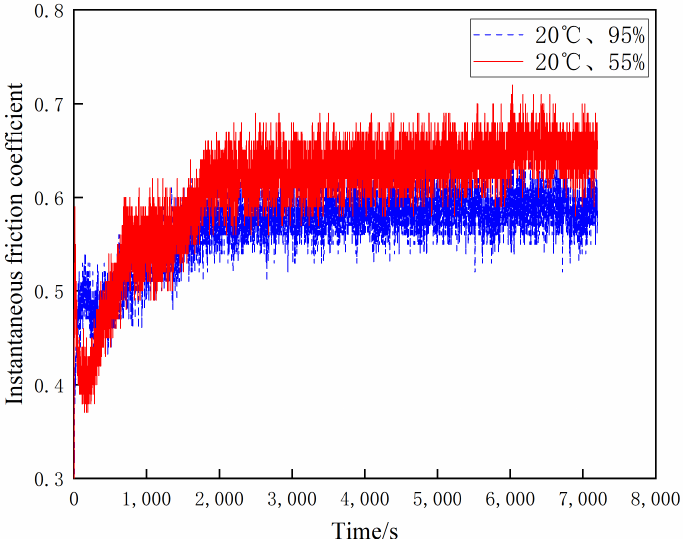
Figure 7. Friction coefficient diagram for different ambient humidity at 20 °C.